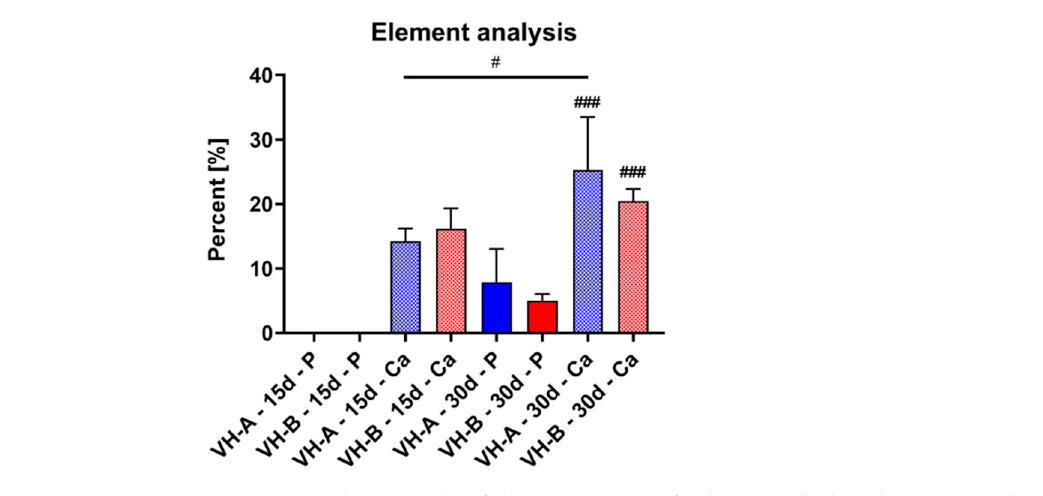
Figure 7. Analysis results of the percentages of calcium and phosphate ions within the implantation beds of both hydrogels hydrogels (colored bars = phosphate ions, riffled bars = calcium ions) (# = intra-individual significances, # p ≤ 0.05, ### p ≤ 0.001).